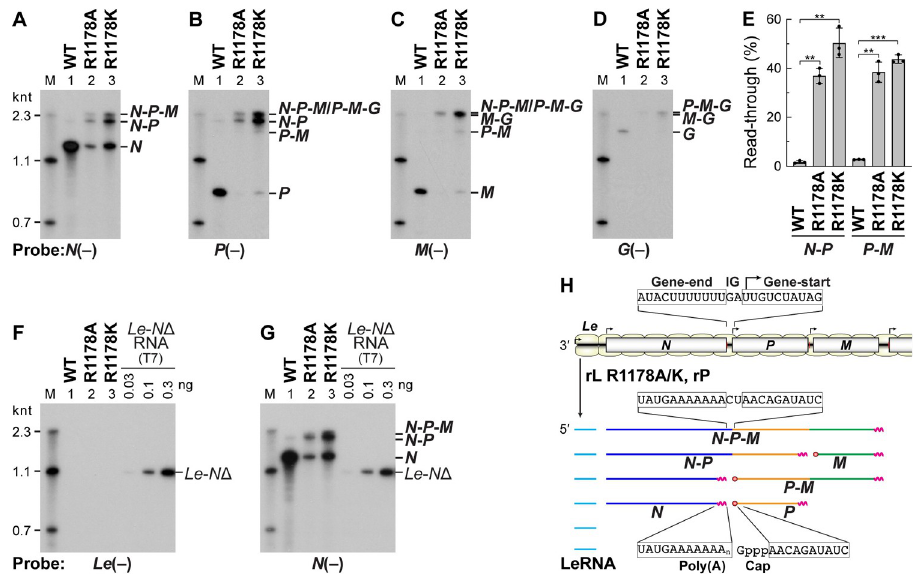
Fig 5. The R1178 mutations trigger the production of polycistronic mRNAs by diminishing polyadenylation- coupled termination at the gene-end sequences. mRNAs were synthesized with the WT or mutant L protein, and analyzed by 5% urea-PAGE followed by Northern blotting using 32 P-labeled oligo-DNA probes complementary to N ( A and G ), P ( B ), M ( C ), and G ( D ) mRNAs and positive-strand leader ( Le ) region ( F ) (named N ( − ), P ( − ), M ( − ), G ( − ), and Le ( − ), respectively). M lanes indicate RNA size markers. ( E ) Percentages of read-through at the N - P and P - M junctions were calculated by densitometric analysis of band intensities of the terminated and read-through mRNAs on the N ( A ) and P ( B ) blots, respectively. The dot-plots, columns, and error bars represent the individual values, means, and standard deviations, respectively (n = 3). Statistical significance was determined by one-way ANOVA [ns, not significant (p � 0.05); � , p < 0.05; �� , p < 0.01; ��� , p < 0.001; ���� , p < 0.0001; compared to control (WT)]. In panels ( F ) and ( G ), an RNA containing the Le region and a part of N region ( Le - N Δ ) was synthesized by T7 RNA polymerase and used as a positive control. ( H ) A schematic diagram of transcripts (lower) synthesized from the genome (upper) by the R1178 mutants is shown. The Le , N , P , and M regions in transcripts are colored in cyan, blue, orange, and green, respectively. Partial nucleotide sequences of the genome and transcripts are shown. IG indicates the intergenic sequence.